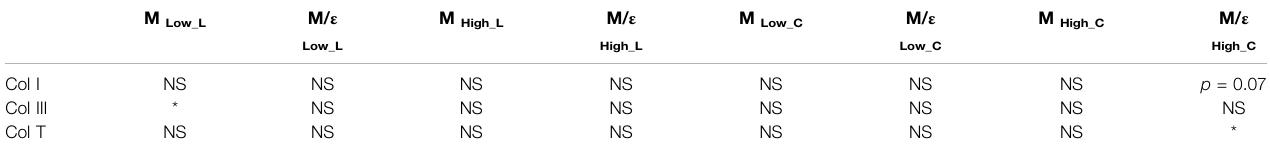
TABLE 4 | Summary of all correlation results between the collagen content and the mechanical properties of all LV and RV samples. M